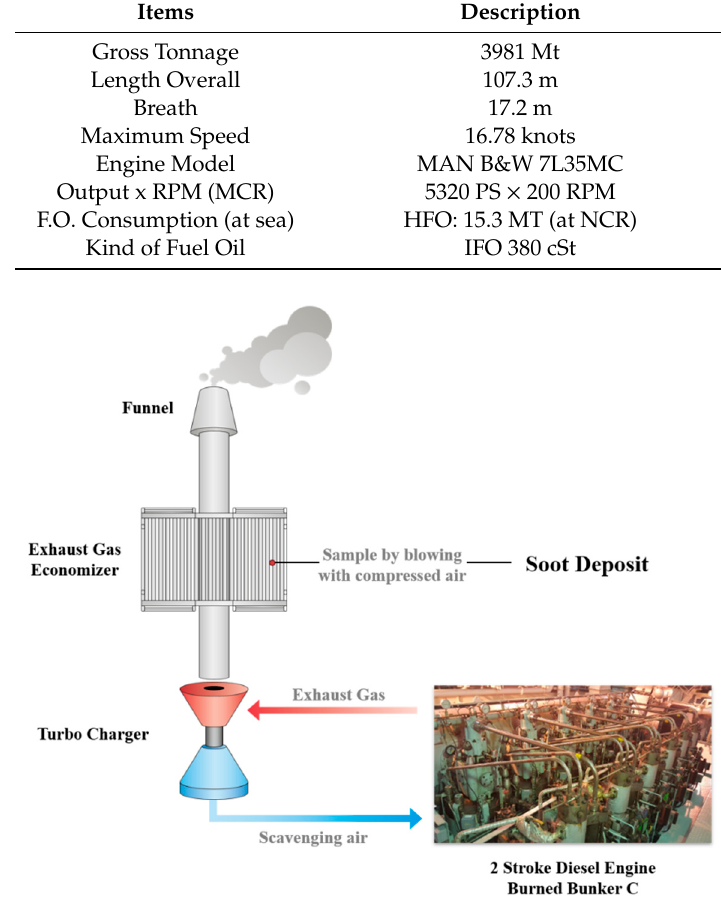
Figure 1. Schematic of soot sampling. Table 2. Engine specifications. Table 1. Technical description of the container ship (M/V SUNNY SPRUCE).